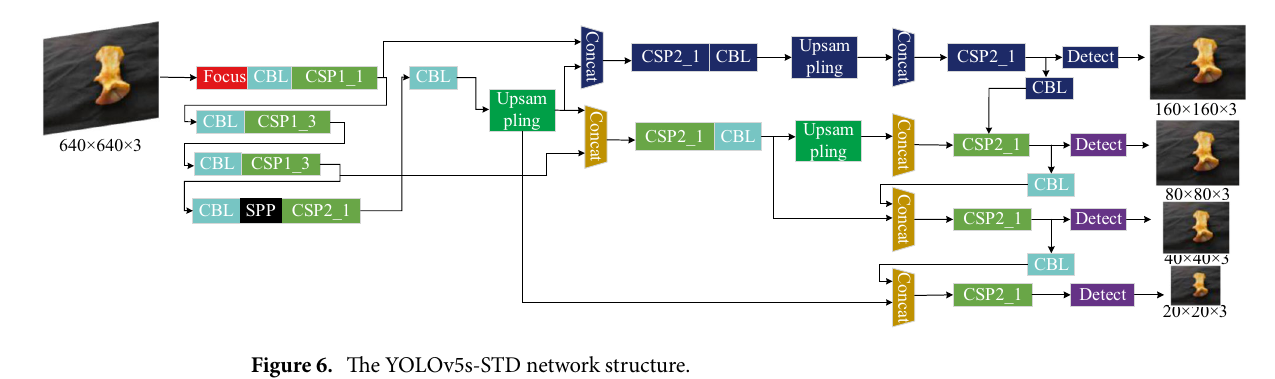
Figure 5. The SE-Net module structure.